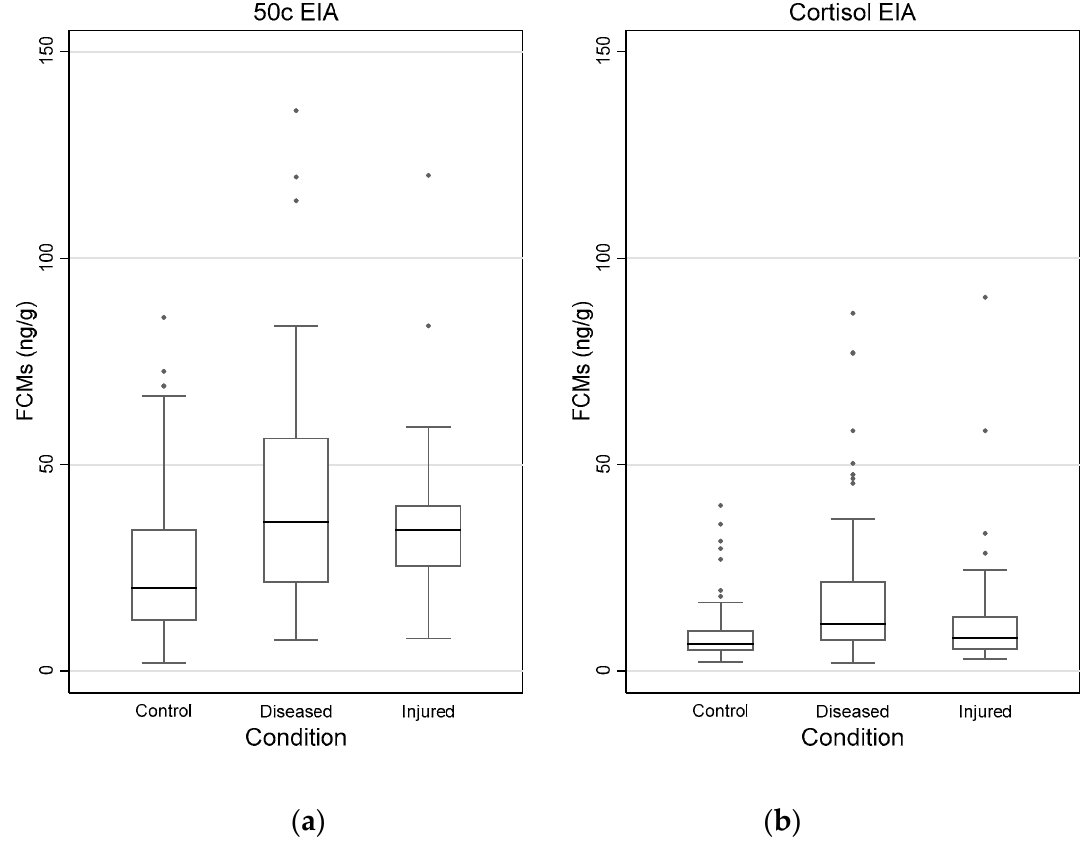
Figure 6. Box and whisker plots showing FCM (faecal cortisol metabolite) values (ng/g) of control (N = 124), diseased (N = 76) and injured (N = 30) koalas, measured with the 50c ( a ) and cortisol ( b ) EIAs (enzyme immunoassays) on the first collection day. Note: Megan’s value of >200 ng/g was excluded to avoid distortion of the values in the box and whisker plot.